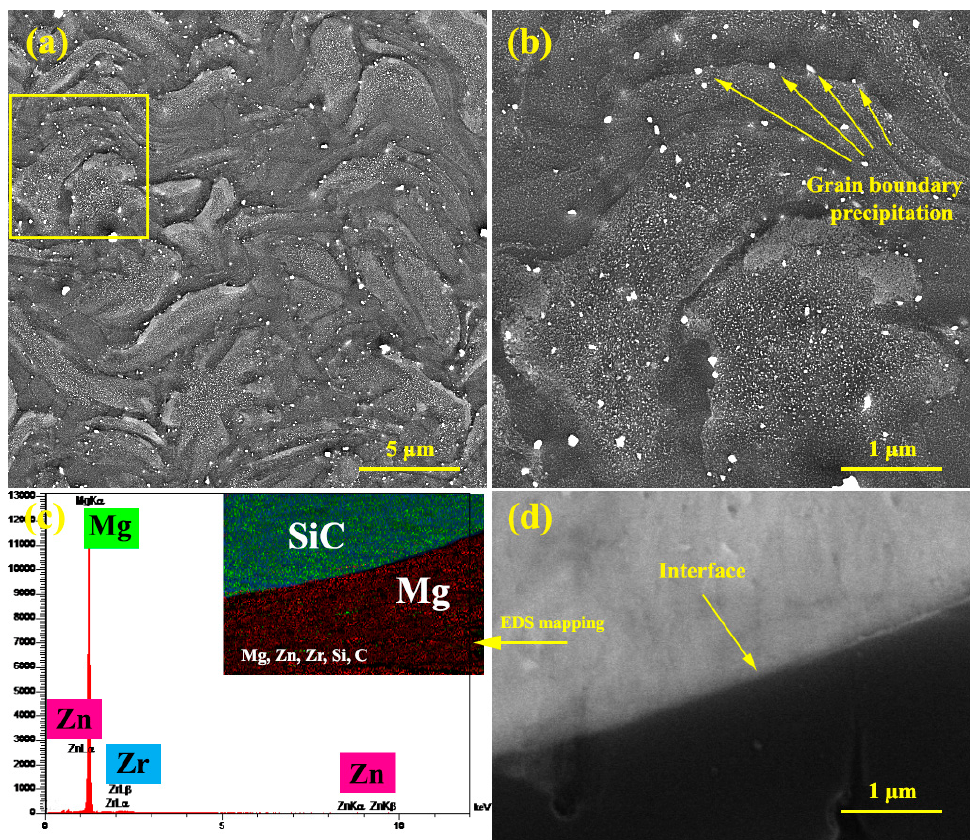
Figure 3. Microscopic image after extrusion and precipitation hardening processes: ( a , b ) unreinforced alloy, ( c ) EDS analysis, and ( d ) particle/matrix interface.